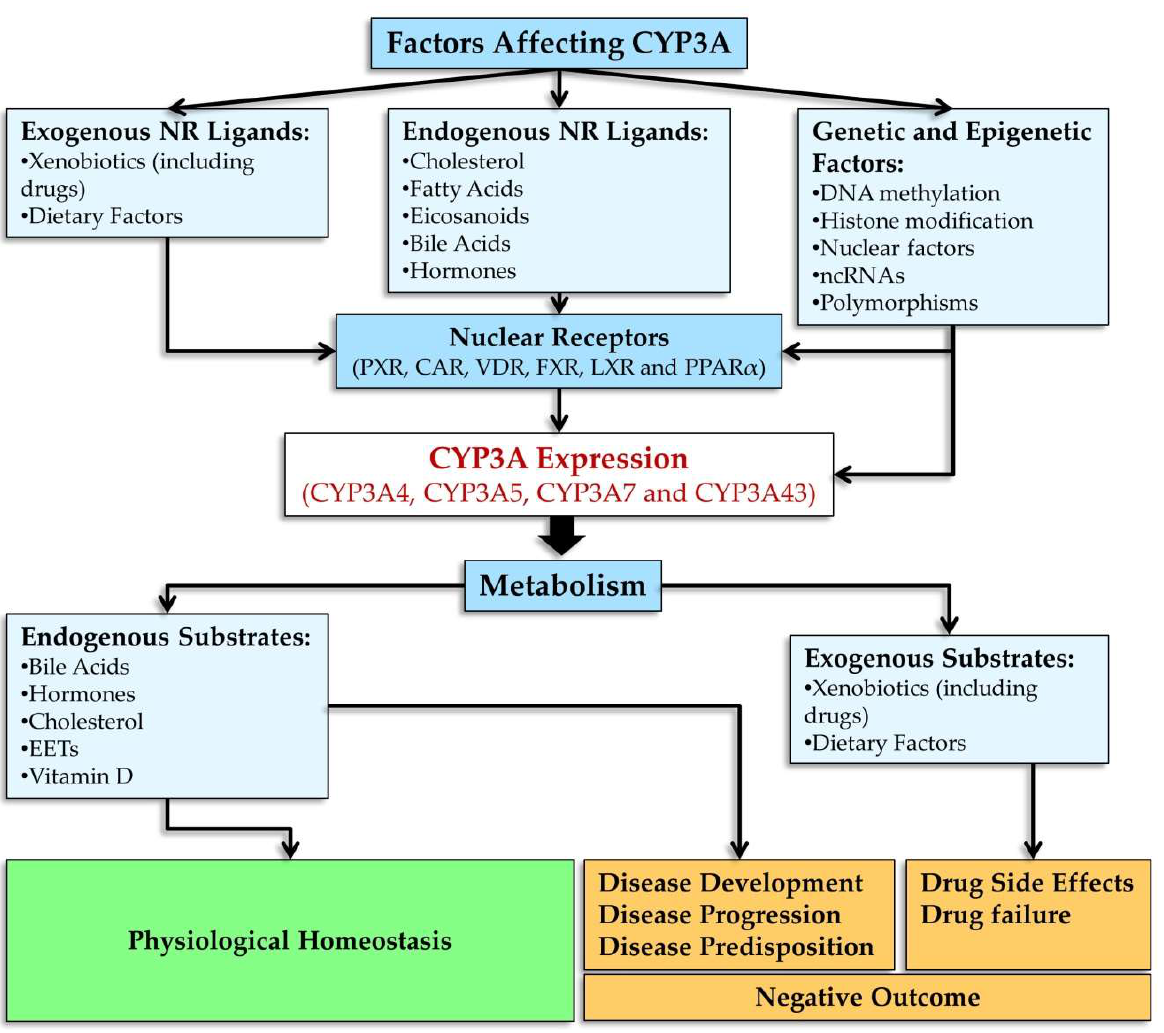
Figure 5. Effects of CYP3A enzymes on the metabolism of endo- and xenobiotics have an influence on a wide range of physiological and pathophysiological processes in the body.